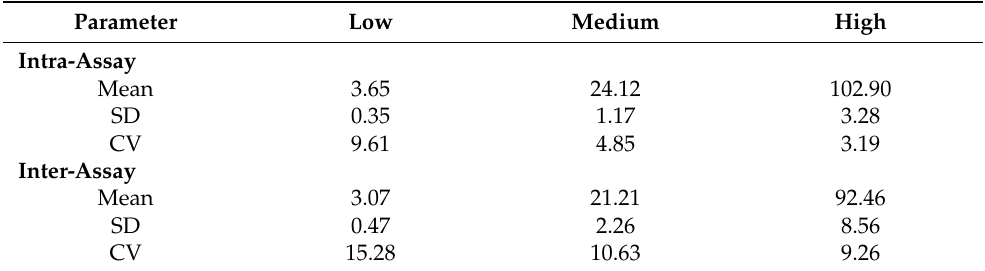
Table 1. Intra- and inter-assay imprecision calculated using pooled sera with a low, medium, and high parathyroid hormone concentration (pg/mL). SD: standard deviation; CV: coefficient of variation.